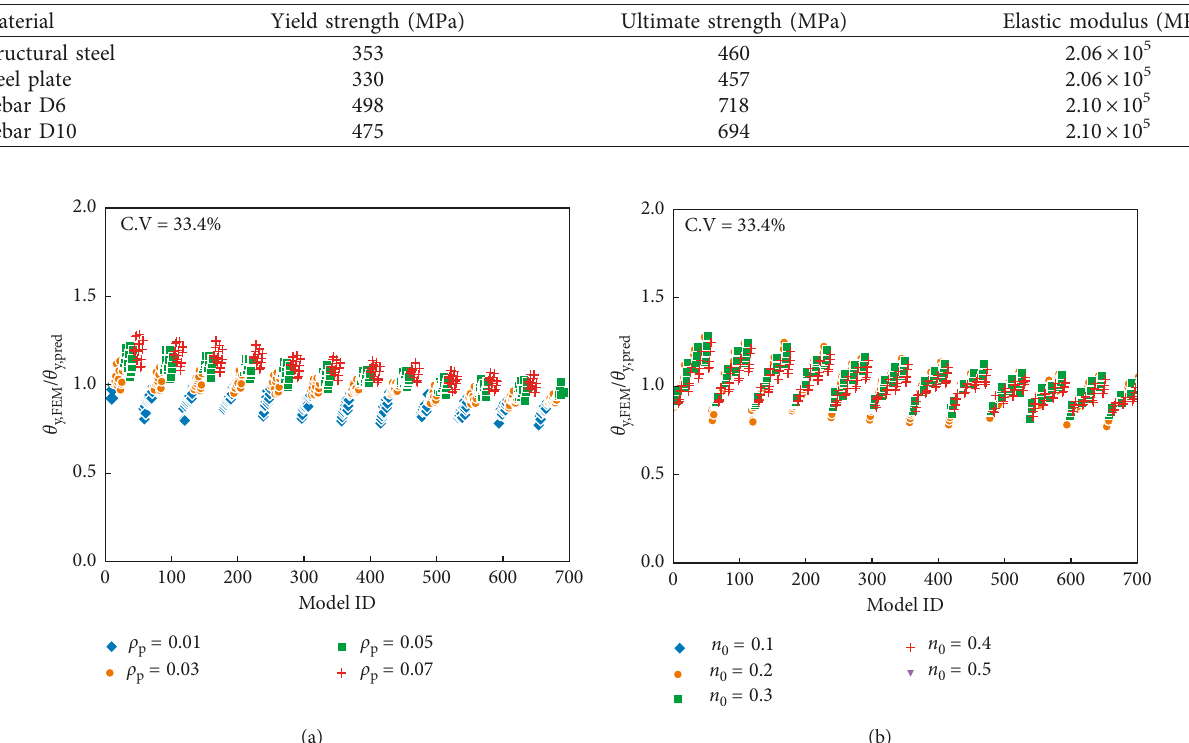
Figure 11: Distribution of yield rotations. (a) Different steel plate ratios. (b) Different axial load